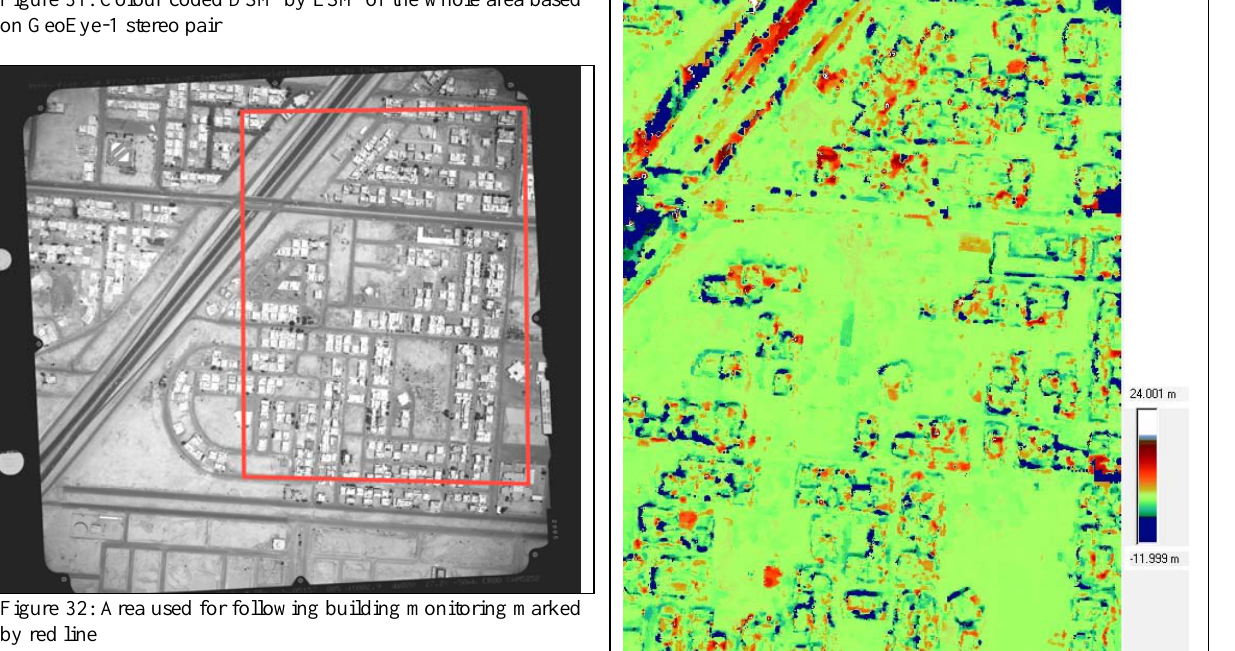
Figure 31: Colour coded DSM by LSM of the whole area based on GeoEye-1 stereo pair